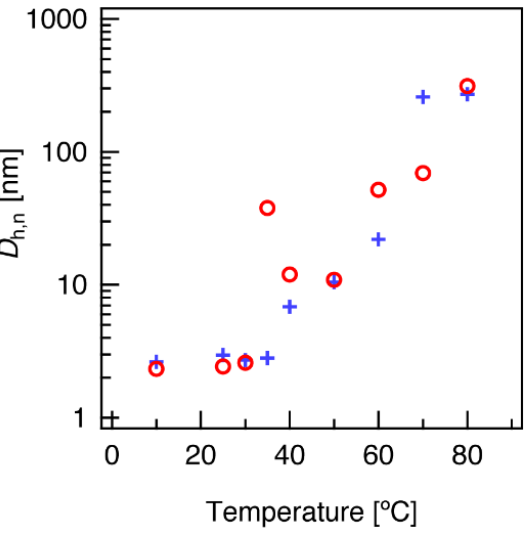
Figure 5. Number-average hydrodynamic diameter ( D h,n ) obtained from dynamic light scattering (DLS) at various temperatures for 10 g/L aqueous solutions of l -L64(OH) (blue cross) and c -L64 (red